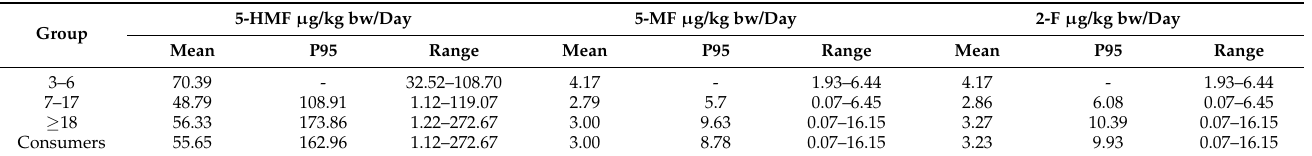
Table 4. Estimation of dietary exposure to furfural and its derivatives from coffee products among Chinese consumers.